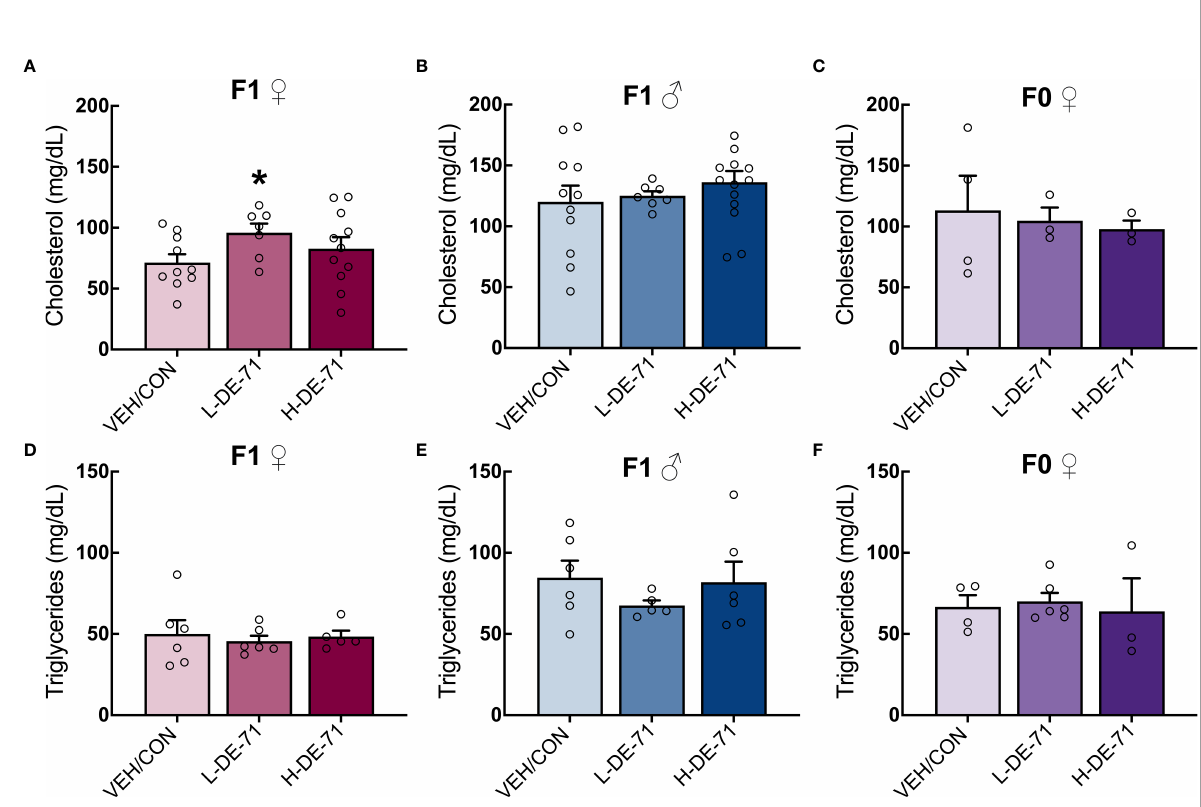
FIGURE 3 Effect of perinatal L-DE-71 exposure on plasma total cholesterol and triglycerides in DE-71-exposed male and female offspring. (A – C) Plasma total cholesterol in female (A) and male (B) offspring and dams (C) . (D – F) Plasma triglyceride levels in female (A) and male (B) offspring and dams (C) . * p <0.05 compared to VEH/CON; Bars and error bars represent mean±s.e.m. Sample size (n/group): (A – C) females, 7-11; males, 7-14; dams, 3-4. (D – F) females, 5-6; males, 5-6; dams,